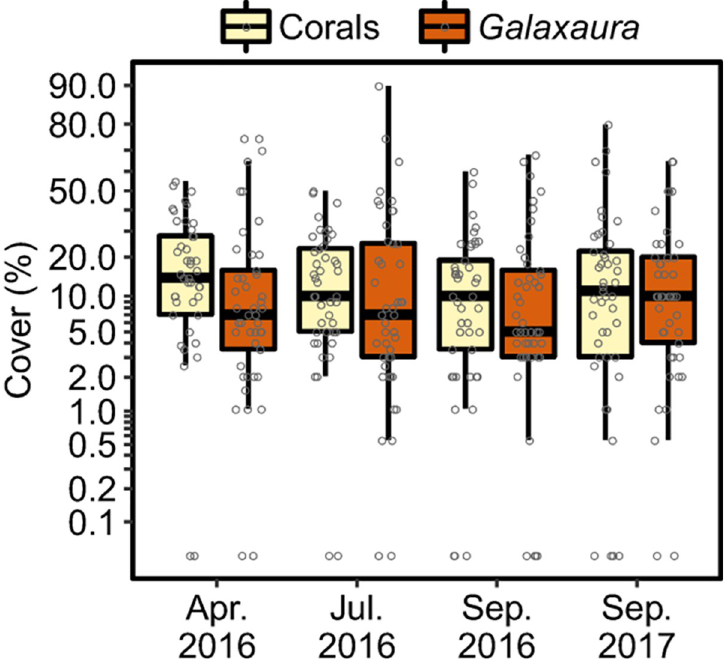
Fig 4. Temporal variation in G . divaricata on a degraded patch reef in the southeast Dongsha lagoon. Boxplots showing variation in the percent cover of two major benthic categories (corals and G . divaricata ) among four time points over a period of 17 months (about 5 m depth at site